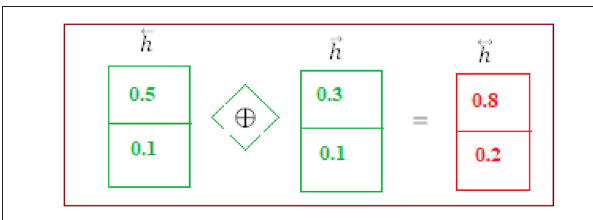
FIGURE 6 | BiSLTM